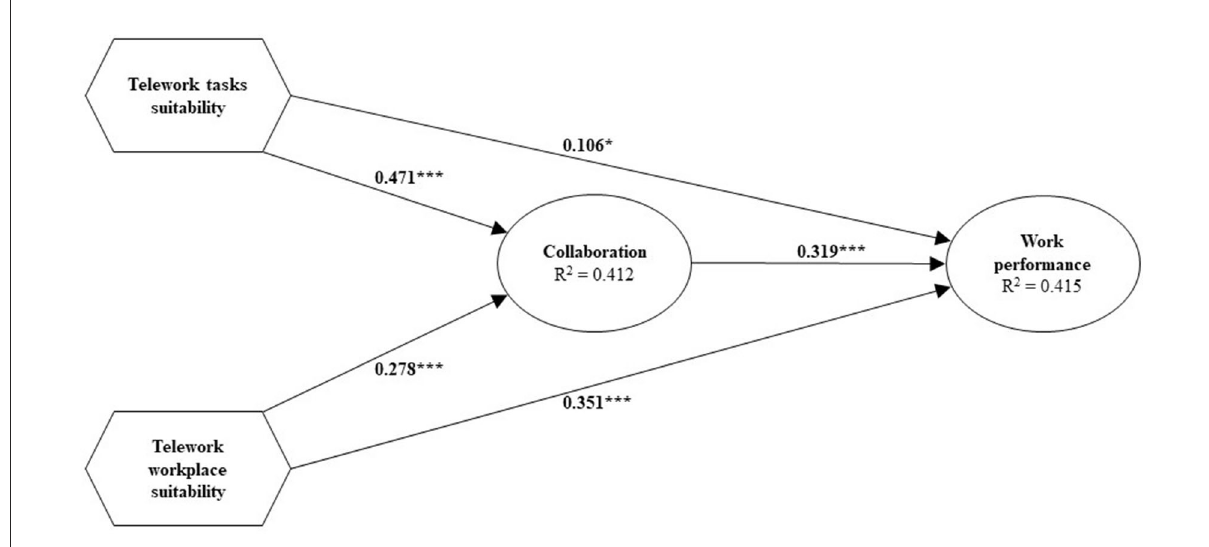
FIGURE2 Results of PLS estimation. *p < 0.05, ** p < 0.01, and *** p < 0.001.